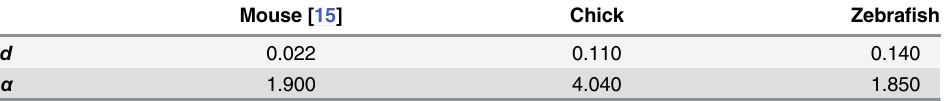
Table 7. Parameters describing the wave deceleration and the geometry of the system for collected data in mouse, chicken and zebrafish somitogenesis. The parameters α and d are computed assuming that the cycle phase φ is random at the time when the embryos are sacrificed